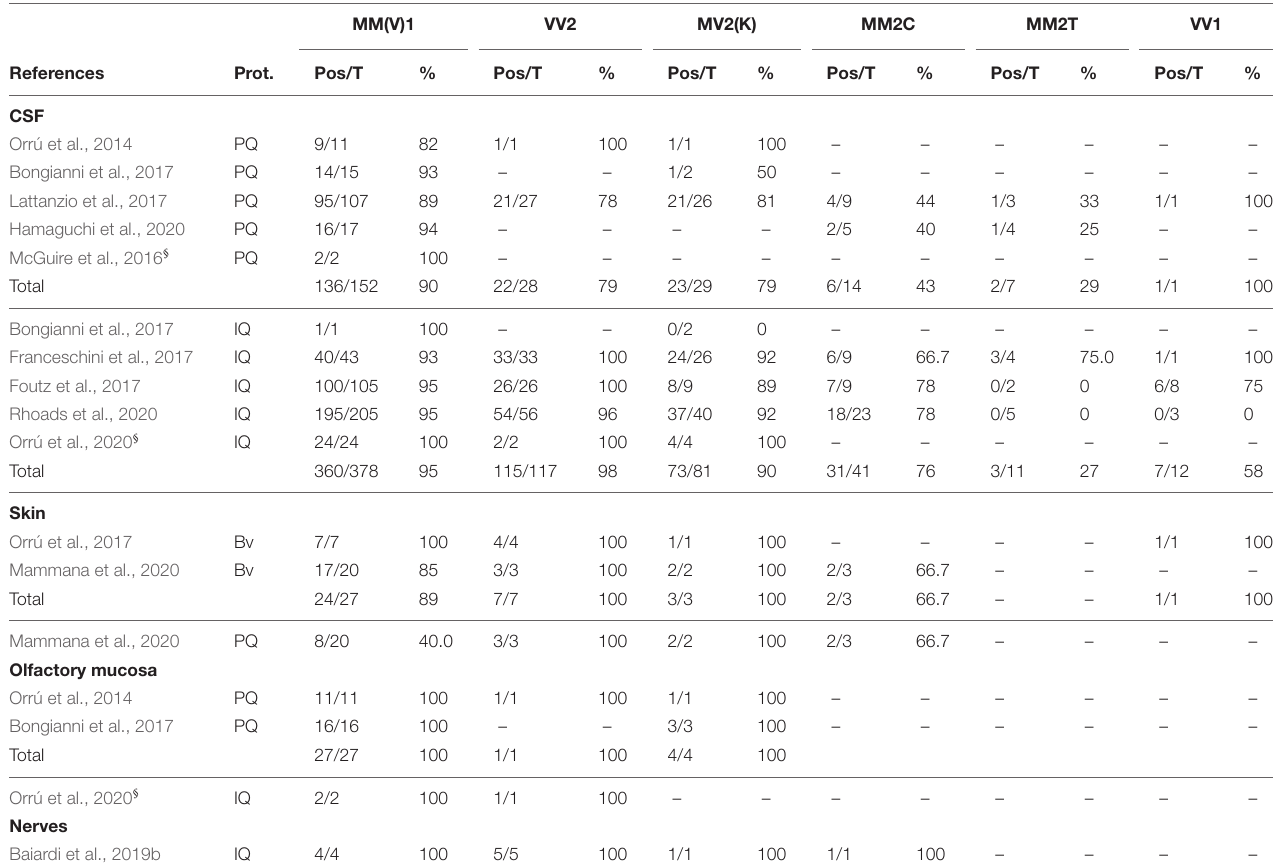
TABLE 5 | Diagnostic performance of the RT-QuIC assay across the spectrum of sCJD